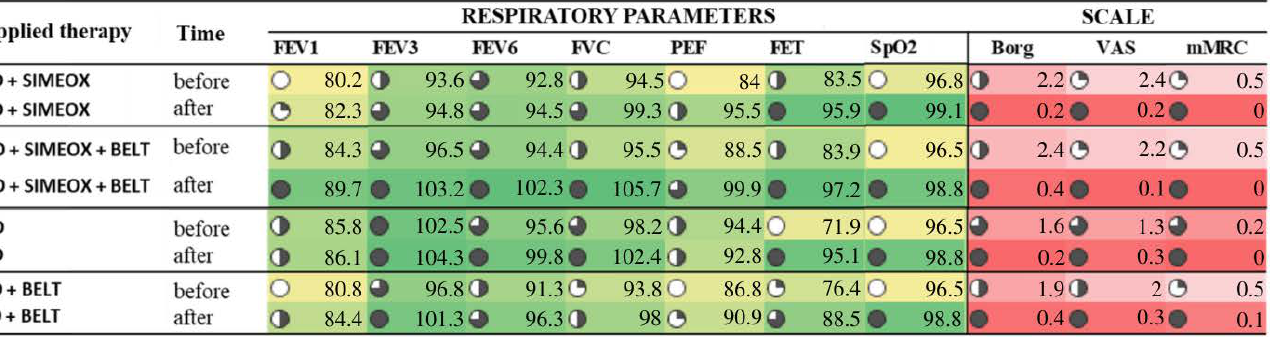
Figure 3. Summary of the mean values of respiratory and circulatory parameters—as well as the Borg, VAS, and mMRC scores—before and after each therapy. Darkened wheels indicate a positive effect; Green represents the highest values of each parameter, yellow represents the lowest values; Red represents the lowest values, indicating a positive effect in the case of the Borg, VAS and mMRC scales. AD—autogenic drainage; FEV1—forced expiratory volume in 1 s; FEV3—forced expiratory volume in 3 s; FEV6—forced expiratory volume in 6 s; PEF—peak expiratory flow; FET—peak expiratory time; SpO2—percent blood oxygen saturation; Borg—the Borg Rating of Perceived Exertion Scale; VAS—the Visual Analogue Scale; mMRC—modified Medical Research Council dyspnea scale.